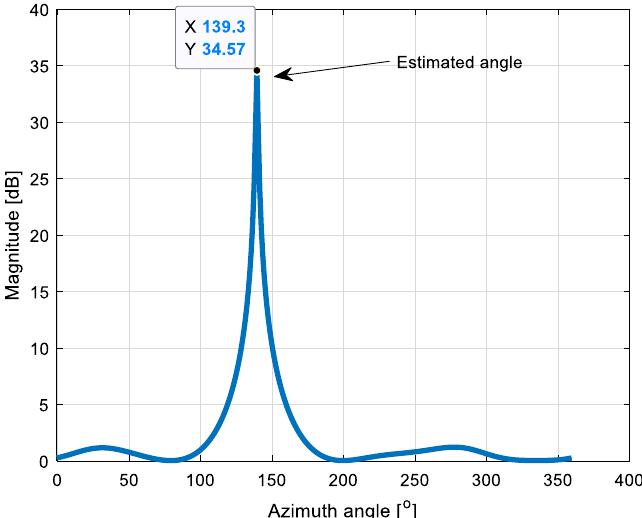
Fig. 3 The magnitude of pseudospectrum function of MUSIC DOA algorithm as a function of azimuth angle with a single cylindrical